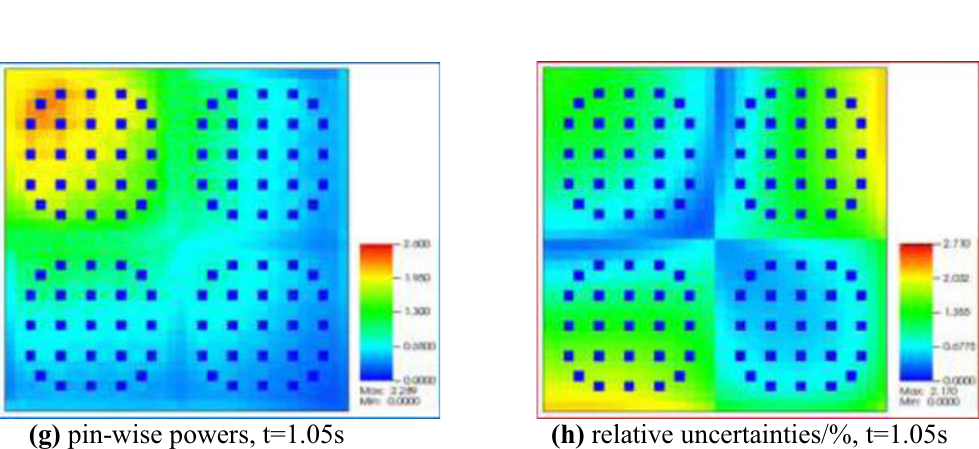
Figure 4. The pin-wise powers and corresponding relative